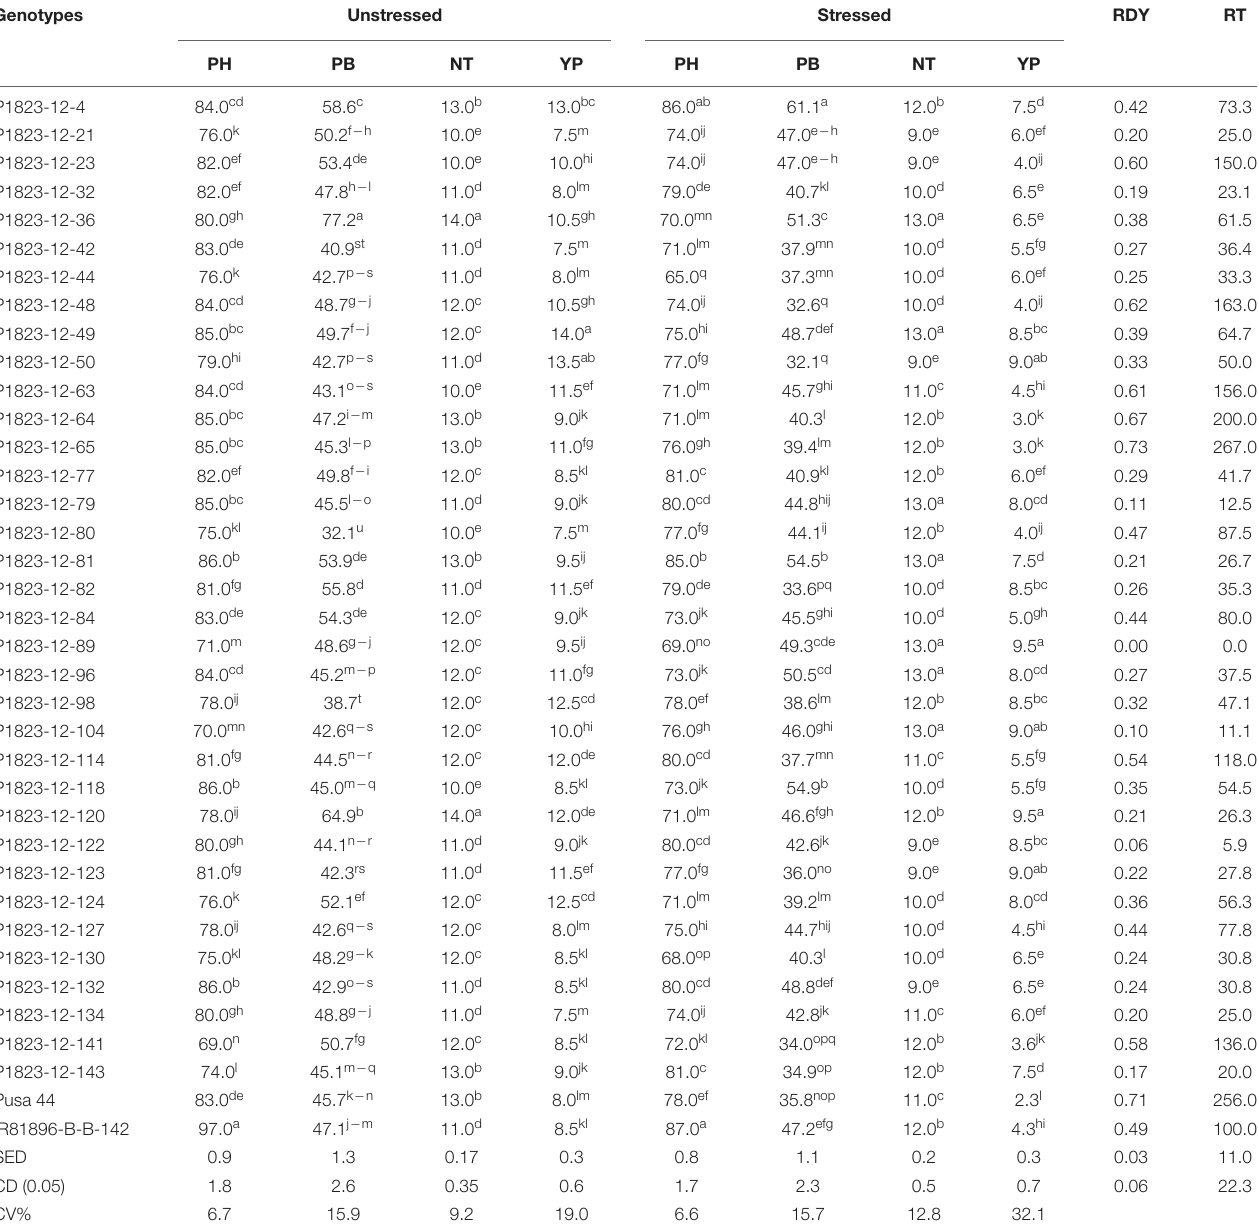
TABLE 3 | The average performance of NILs and their relative tolerance under stress in the pot experiment under drought stress and unstressed conditions. Genotypes Unstressed Stressed RDY